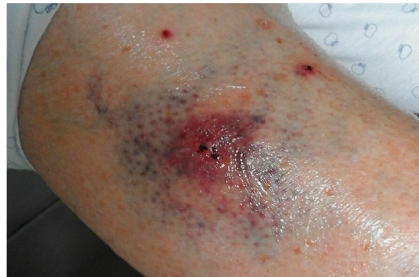
Figure 1: The cat bite on the right leg of the patient.